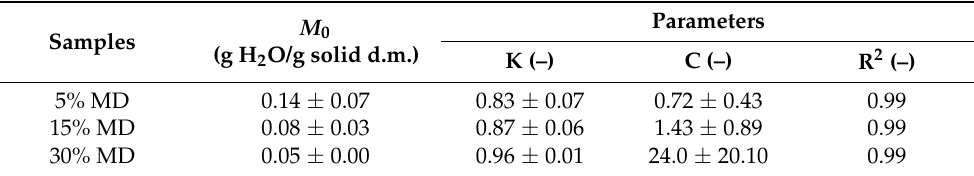
Table 2. Calculated GAB model parameters for the adsorption isotherms of the raspberry foams at 25 °C. The samples contained 5% ( w / w ) PP + 2.5% ( w / w ) P at various MD concentrations.